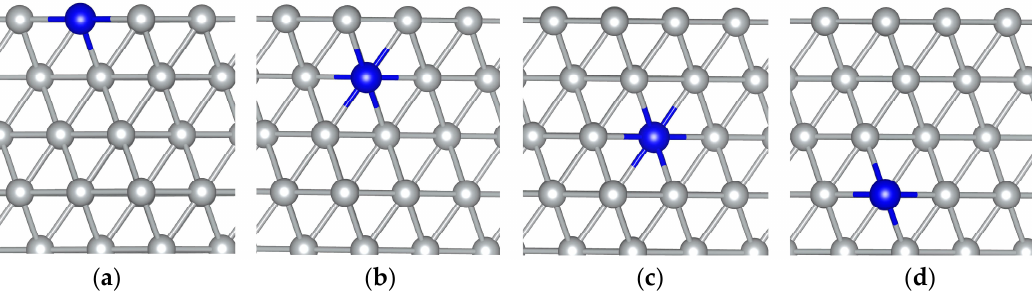
Figure 1. MoNi(111) alloy systems showing one Mo monomer substituting one Ni atom in the ( a ) first; ( b ) second; ( c ) third; and ( d ) fourth nickel layer. Only the four top layers are shown. Gray and blue balls represent Ni and Mo atoms, respectively.